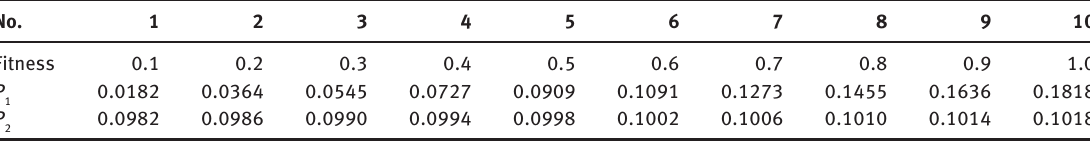
is Equal to 5000. c